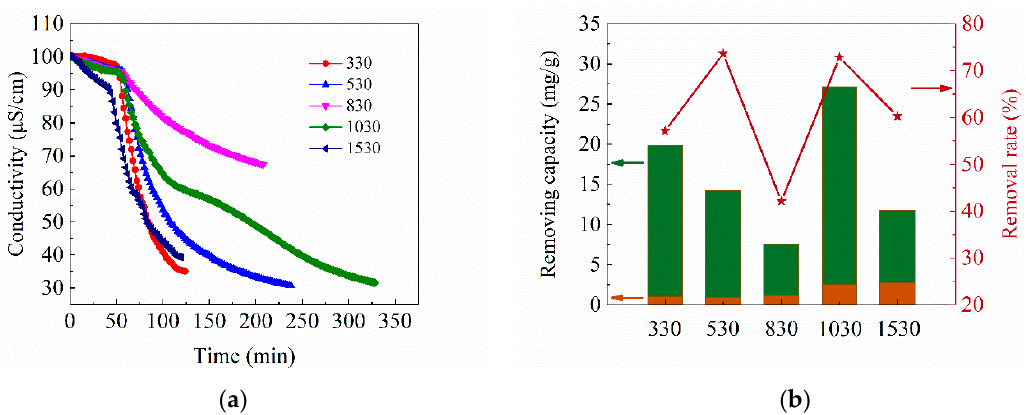
Figure 5. ( a ) Adsorption curves and ( b ) the SAC and removal rate of CAs with different R/C in CuSO 4 solution. The orange area in (b) represents the specific adsorption during the open circuit, and the green area represents the electrosorption capacity.